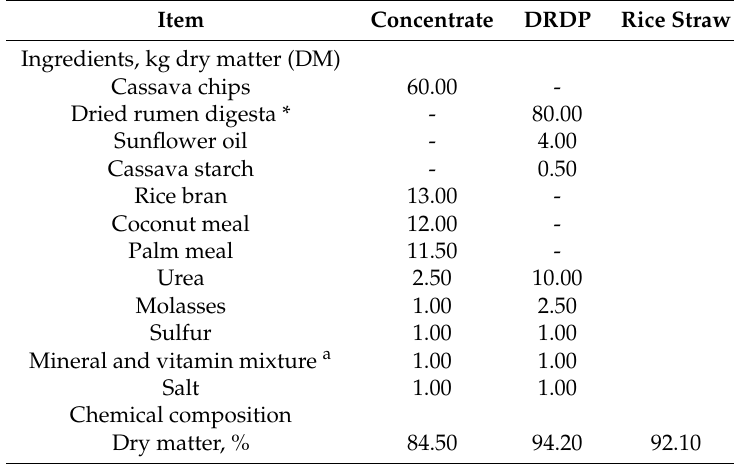
Table 1. Ingredient and chemical composition of the concentrate, dried rumen digesta pellets (DRDP), and rice